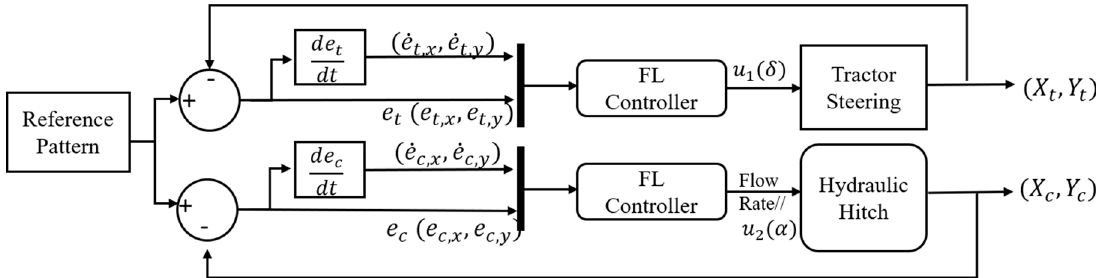
Figure 5. Tractor-Cart adaptive control block model.